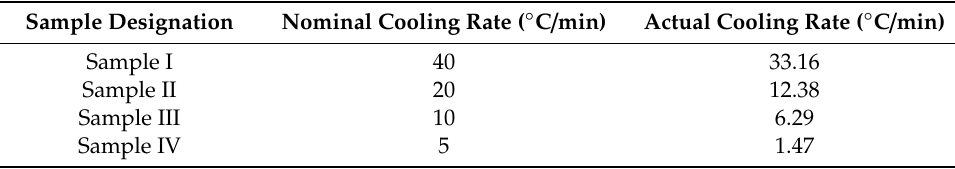
Table 4. Nominal and actual cooling rates for Nylon-12 samples tested non-isothermally in